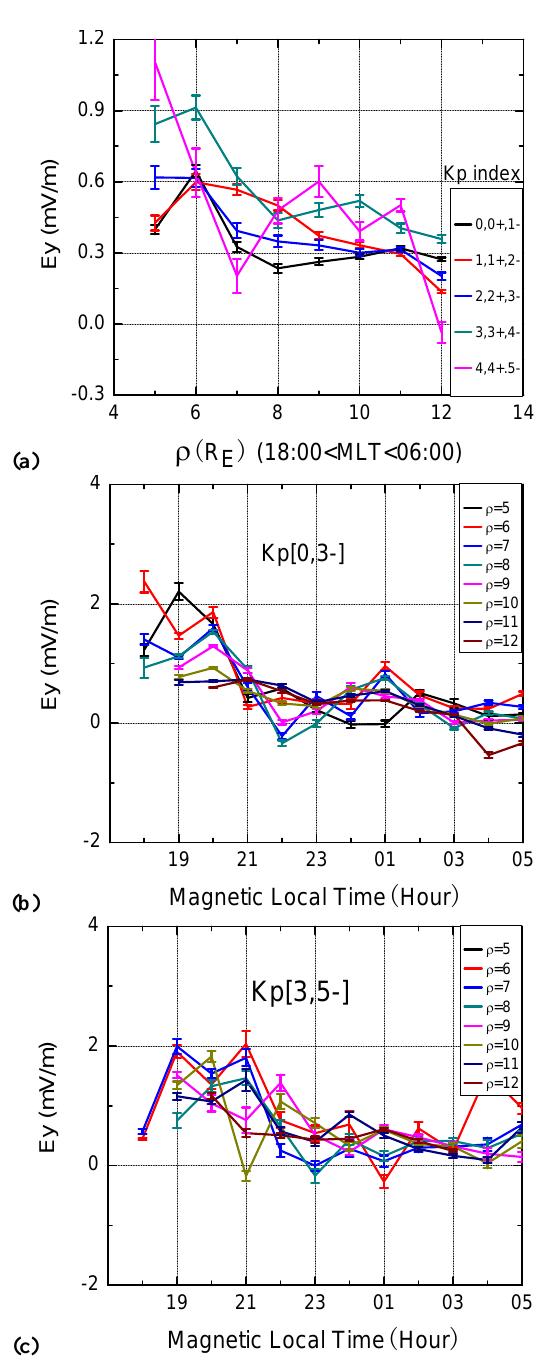
Figure 3. (a)The variation of the dawn-dusk component of the electric field as a function of ρ value and geomagnetic activity Kp index. (b) The variation of the Ey component of the electric field as a function of magnetic local time for geomagnetic activity Kp less than 3. (c) The variation of the Ey component of the electric field as a function of magnetic local time for geomagnetic activity Kp between 3 and 5-.